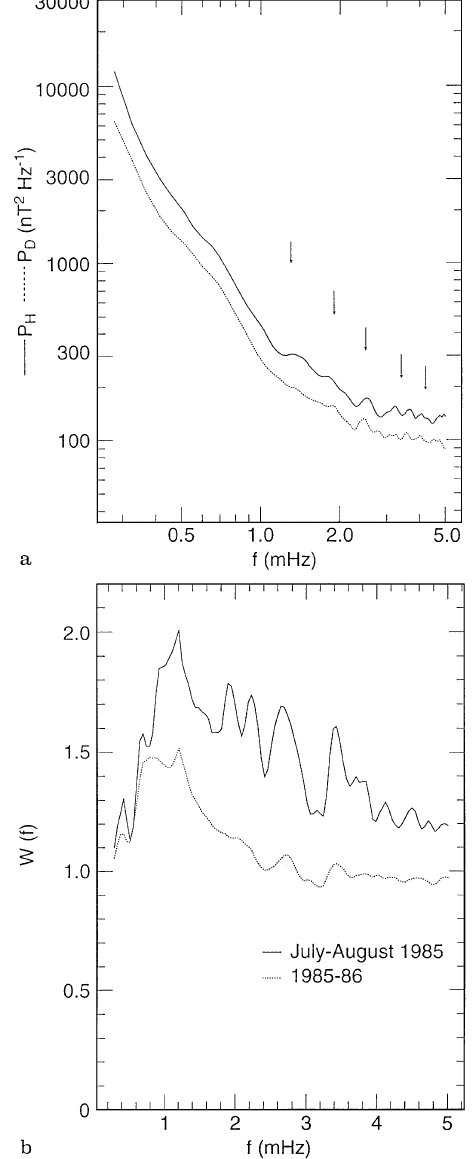
Fig. 5. a Daytime power spectra (log ! log scale) of the horizontal components H and D for the two-month interval July — August 1985; b the … ratio between the H and D nighttime spectral densities for the two-month interval July — August 1985 ( solid line ) and for the whole interval 1985 — 1986 ( dotted line